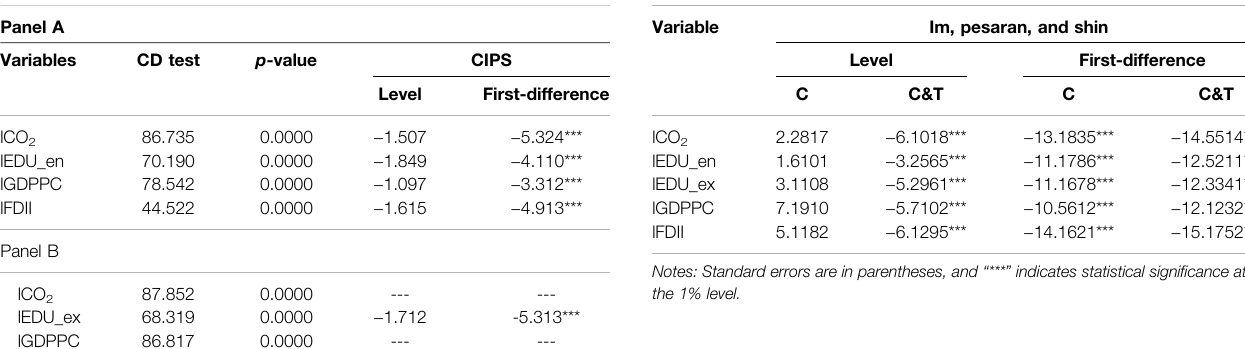
TABLE 4 | Panel unit root (im, pesaran, and shin)